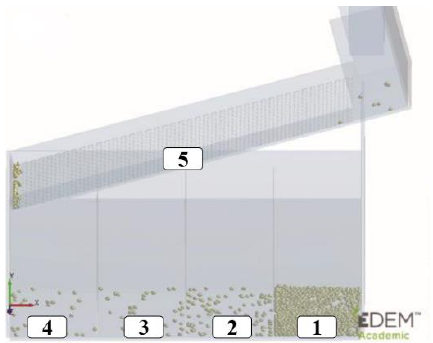
Figure 10. The statistical areas of self-flow screening simulation.